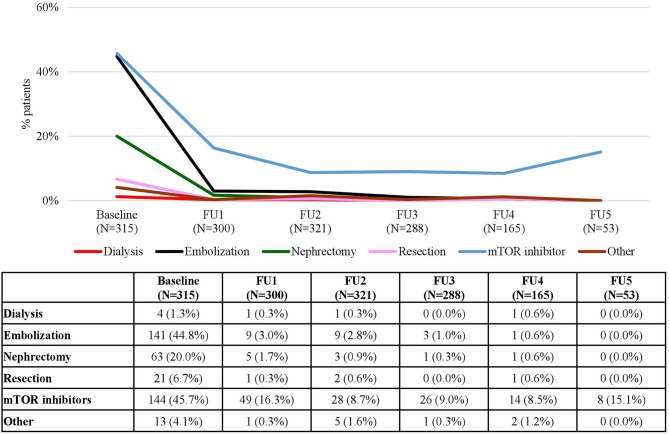
rAML Treatments according to Follow-Up. Patients may receive more than one treatment. Baseline data refers to patients who “ever had” the manifestation.